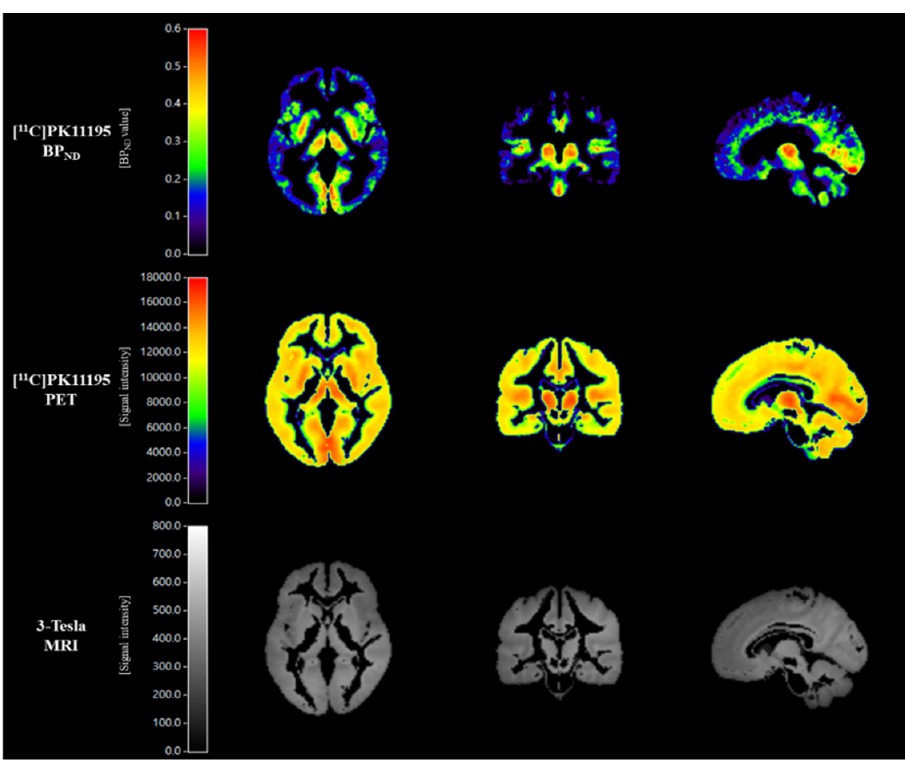
Figure 1. Representative mean images of [ 11 C]PK11195 BP ND , [ 11 C]PK11195 PET, and corresponding 3-Tesla MRI in the control group.